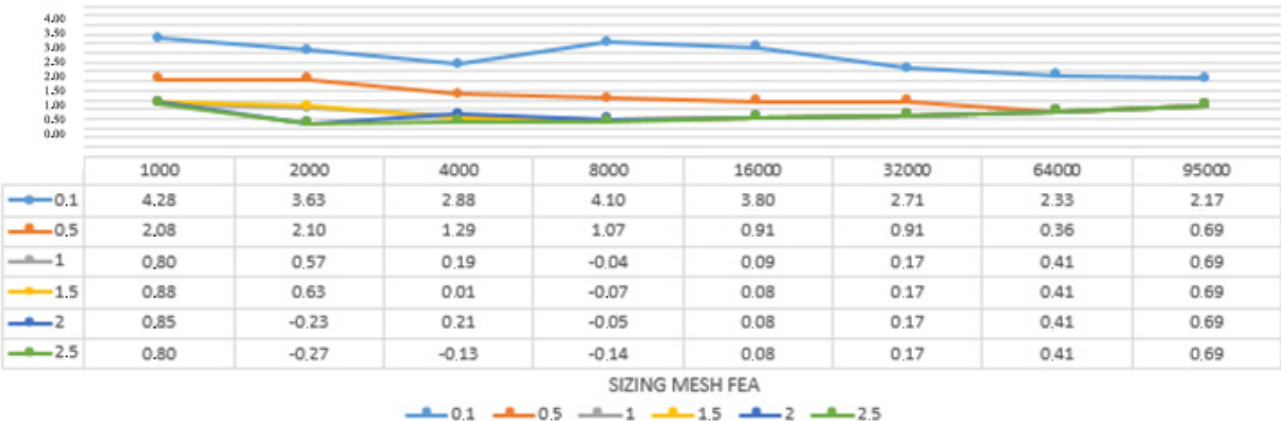
Figure 10. Convergence analysis for the models simplified with retopology and the adaptive size parameter fixed at 100. In yellow, the results gone to convergence are expressed in percentage in relation to the result given by the analysis and the analytical result calculated for the specimen. Expressed in a graph.